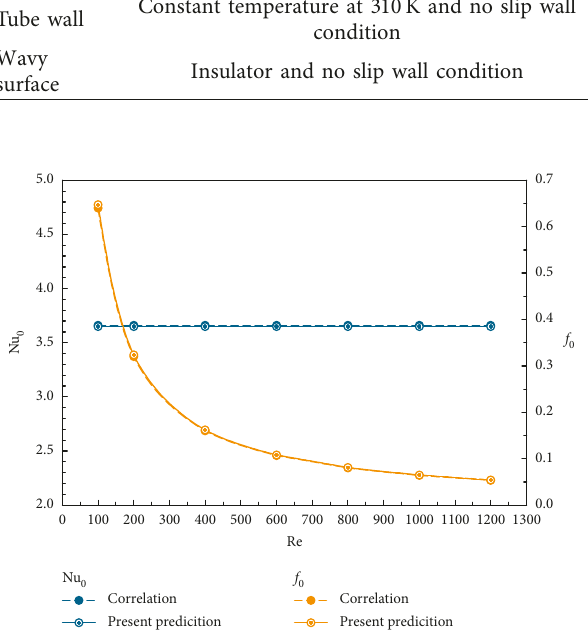
Figure 2: Validation of the smooth circular tube for the laminar